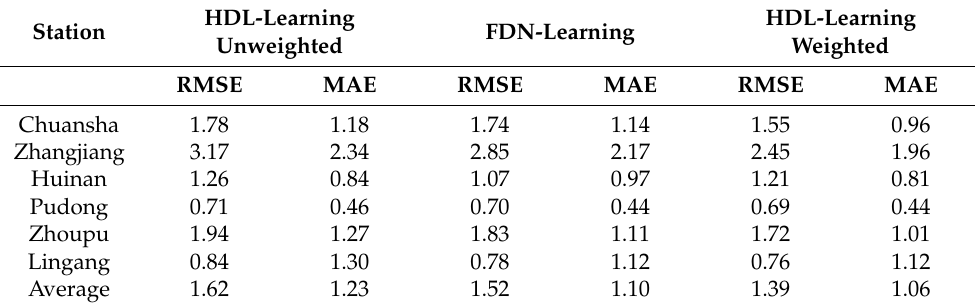
Table 7. Performance comparison of weighted and unweighted